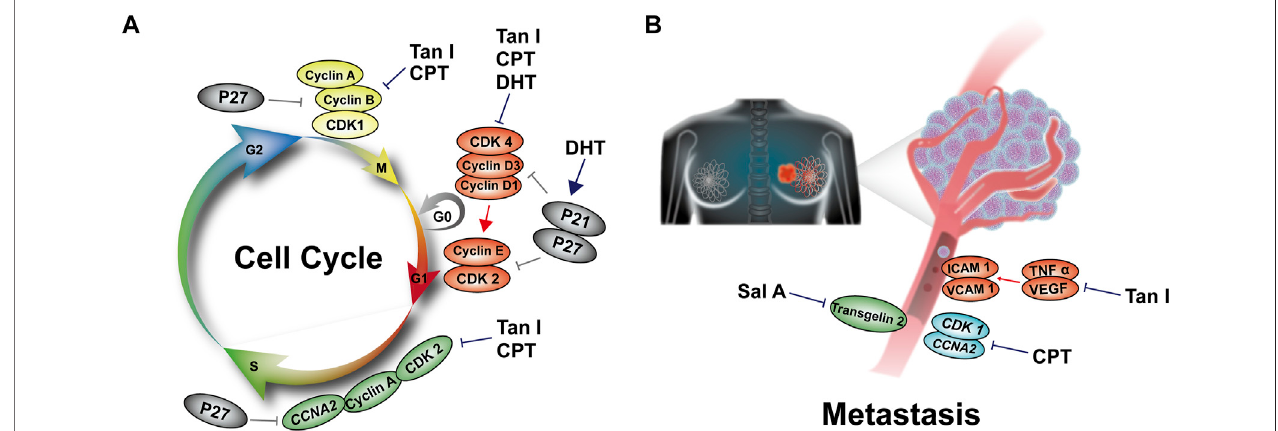
FIGURE 4 | The mechanisms by which S. miltiorrhiza bioactive constituents induce breast cancer cell cycle and metastasis. (A) DHT inhibits expression of Cyclin D1, Cyclin D3, Cyclin E, and CDK4, in contrast, while increasing p21 and p27 expression, leading to G1 arrest. CPT inhibits levels of Cyclin A, Cyclin B, Cyclin D, and CDK2expression,resultinginarrestatG1arrest.TanIinhibitslevelsofCyclinA,CyclinB,CyclinD,CyclinE,andCDK4,leadingtocellcycleG1,S,orG2/Mphasearrest. (B) SalAinhibitsTransgelin2expression.TanIinhibitsICAM-1,VCAM-1,TNF- α ,andVEGFexpression.CPTinhibits CDK1 and CCNA2 geneexpression,resulting in the suppression of breast cancer metastasis.